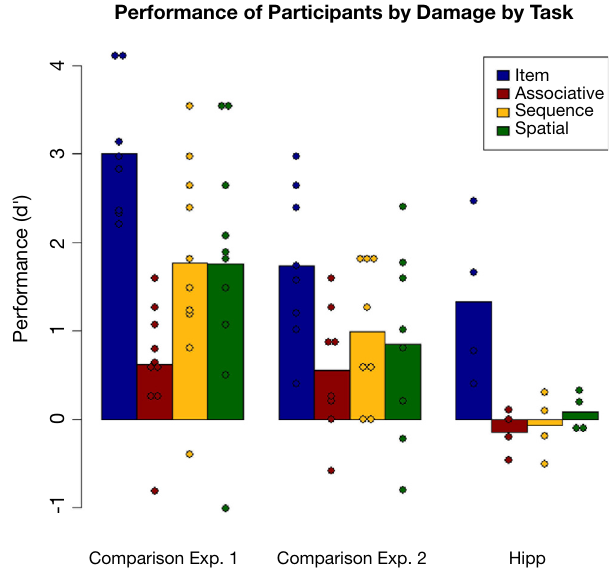
Figure 8 | Performance by the comparison group on each task in Experiment 2, plotted along with performances by the comparison and hippocampal groups from Experiment 1. Individual participant scores are again plotted over the means.